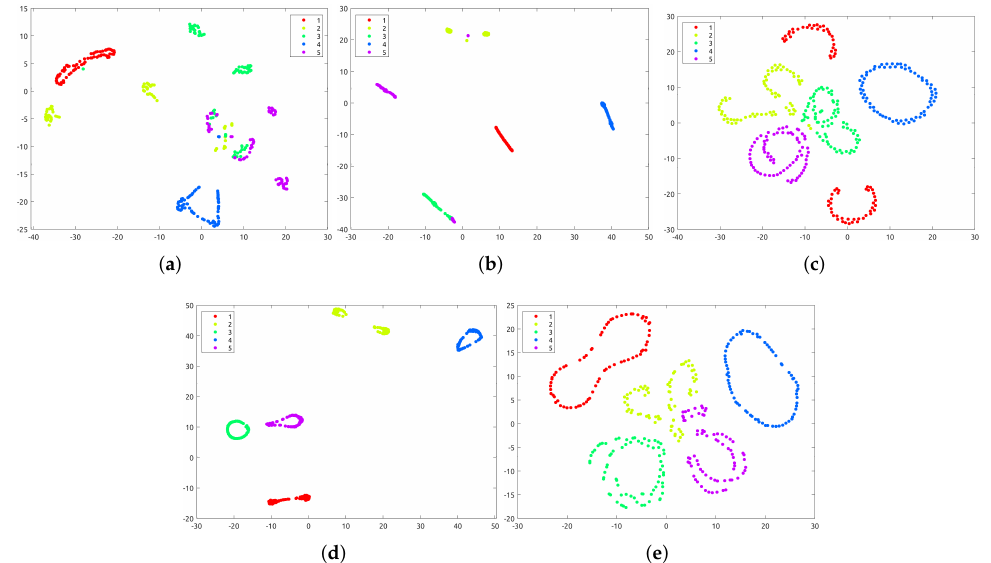
Figure 2. Visualization of the clustering results of the first 5 classes of COIL-20 with t-SNE. ( a ) MLAN.